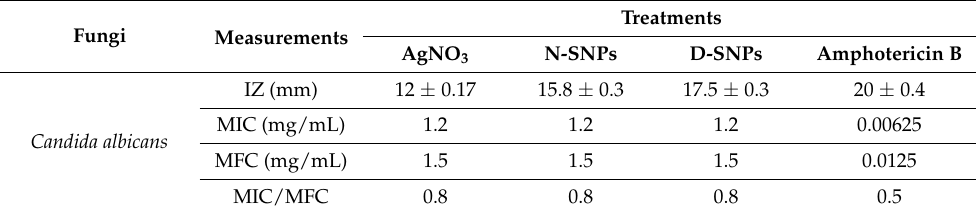
Figure 1. Fungicidal activity of amphotericin B, Ag-NPs fabricated by Nostoc sp. Bahar_M and Desertifilum sp. IPPAS B-1220 (N-SNPs and D-SNPs, respectively), and silver nitrate (AgNO 3 ) against Candida albicans . Data were collected from at least three independent assays and are presented as means ± SEM. **** p < 0.0001 vs. untreated C. albicans . Table 2. Inhibition zone diameter (IZD), minimum inhibitory concentration (MIC), and minimum fungicidal concentration (MFC) of AgNO 3 , N-SNPs, and D-SNPs and amphotericin B against Candida albicans.